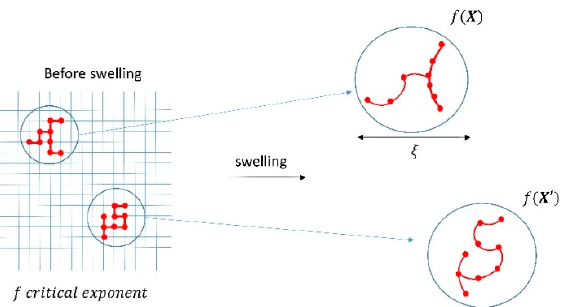
Figure 2. Schematic of the swelling of a gel based on a percolation model. The parameter 𝑝 related to the number of nodes is not modified by the swelling, but the bending of the links between nodes will impact the critical exponent 𝑓 that will now depend on the position translating the weak universality.